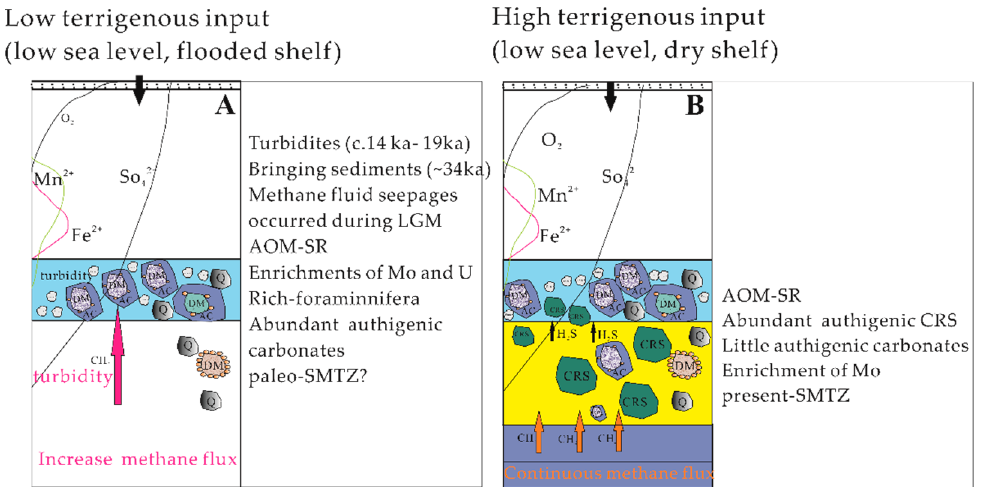
Figure 6. Schematic illustration of relevant depositional and diagenetic processes leading to methane seeping in continental slope setting affected by turbidity during ( A ) and after ( B ) the last glaciation.